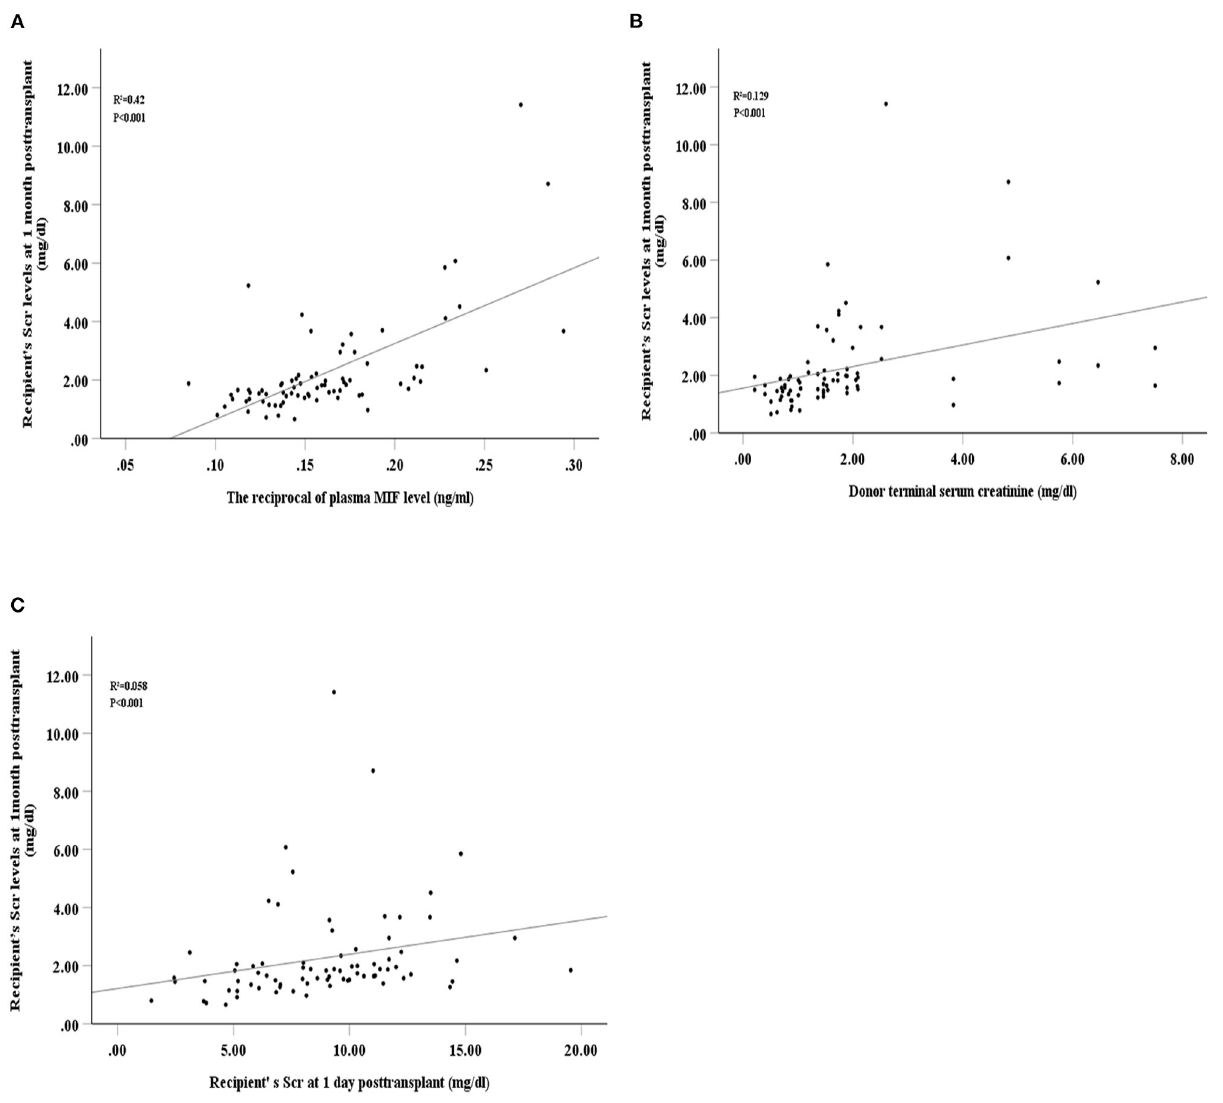
FIGURE 4 | Spearman’s correlation between recipient’s serum creatinine at 1-month post-transplant and intraoperative plasma macrophage migration inhibitory factor (MIF) level (A) , donor terminal serum creatinine (B) , and recipient’s serum creatinine at 1-day post-transplant (C)